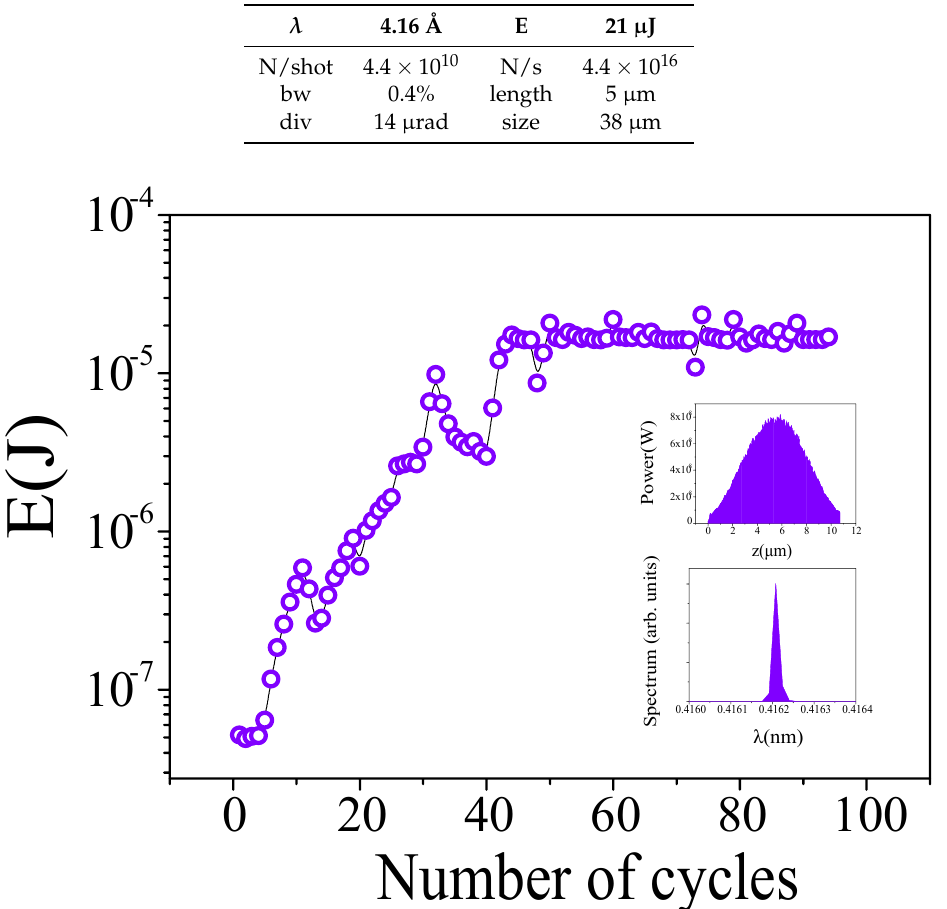
Figure 9. Intracavity radiation of the regenerative amplifier at 4.16 ˚A. In the boxes: power at saturation and